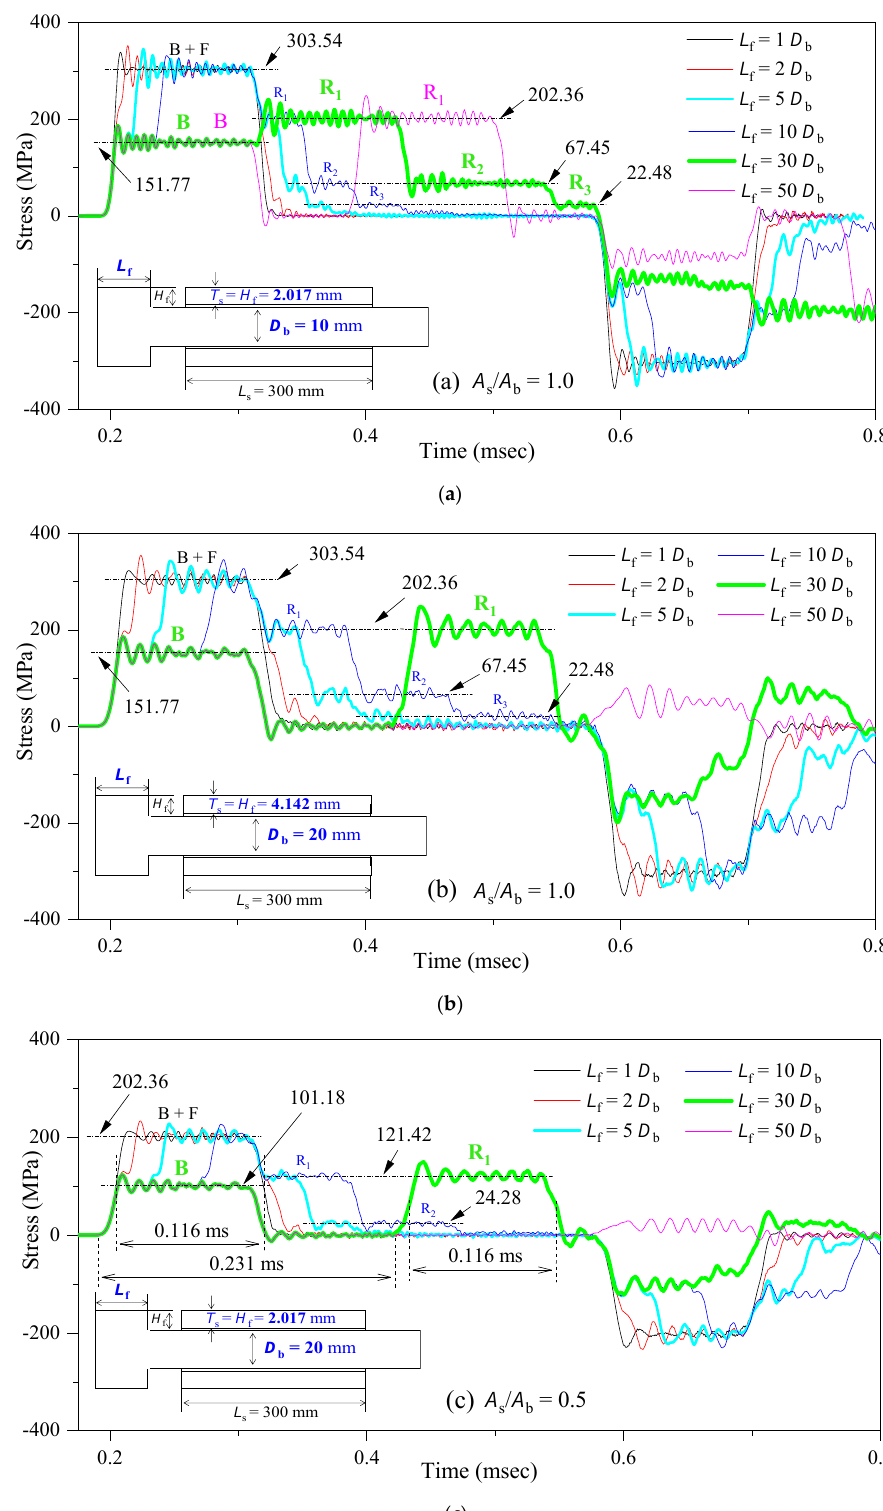
Figure 4. Axial stress ( σ yy ) profiles observed at the strain gauge position for a range of flange lengths ( L f ) at bar diameters ( D b ) of: ( a ) 10 mm ( A s = A b ), ( b ) 20 mm ( A s = A b ), and ( c ) 20 mm ( A s = 0.5 A b ).